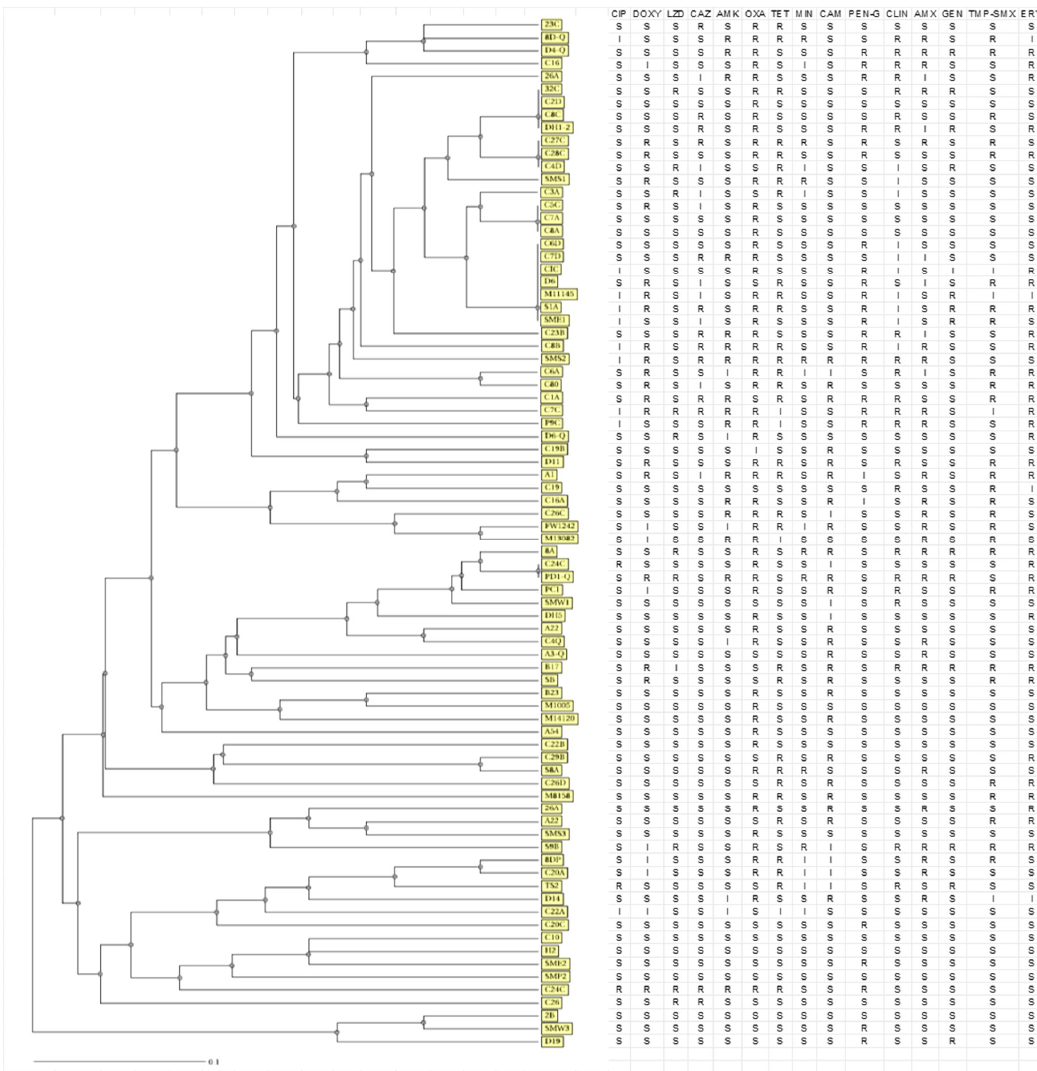
Figure 1. Dendrogram representing the similarity grouping of Staphylococcus aureus clusters based on their susceptibility profiles. The MIRU-VNTR plus service (www.miru-vntrplus.org) was used to compare isolates (resistance coded as 2, susceptible as 1 and intermediate as 1). The differences in susceptibility profiles were used to estimate the distance. The strains were encoded and shown by numbers and letters highlighted in yellow. (CIP: Ciprofloxacin, Doxy: Doxycycline, LZD: Linezoid,